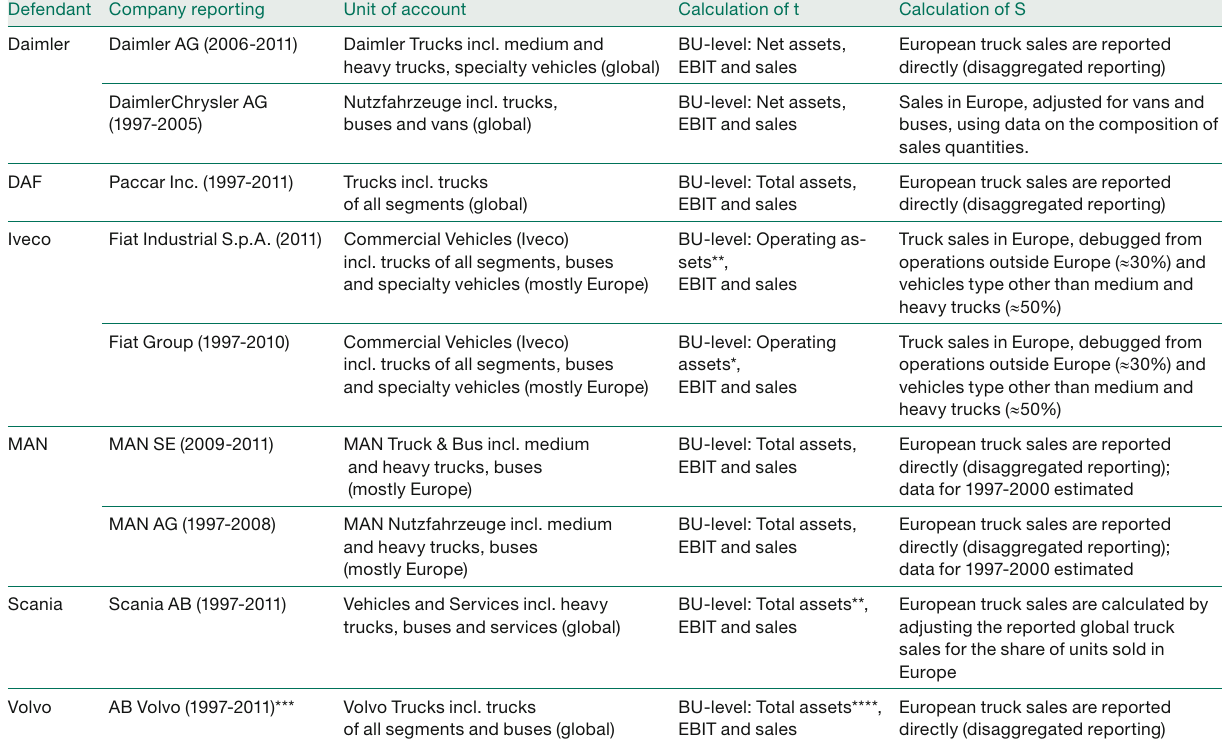
Note: BU-Level stands for business unit